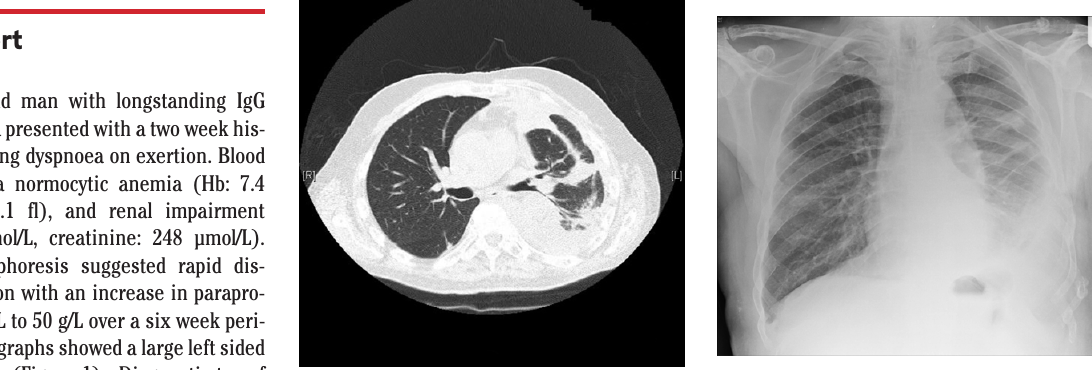
Figure 2. Computed tomography of the chest was radiologically suggestive of mesothelioma.